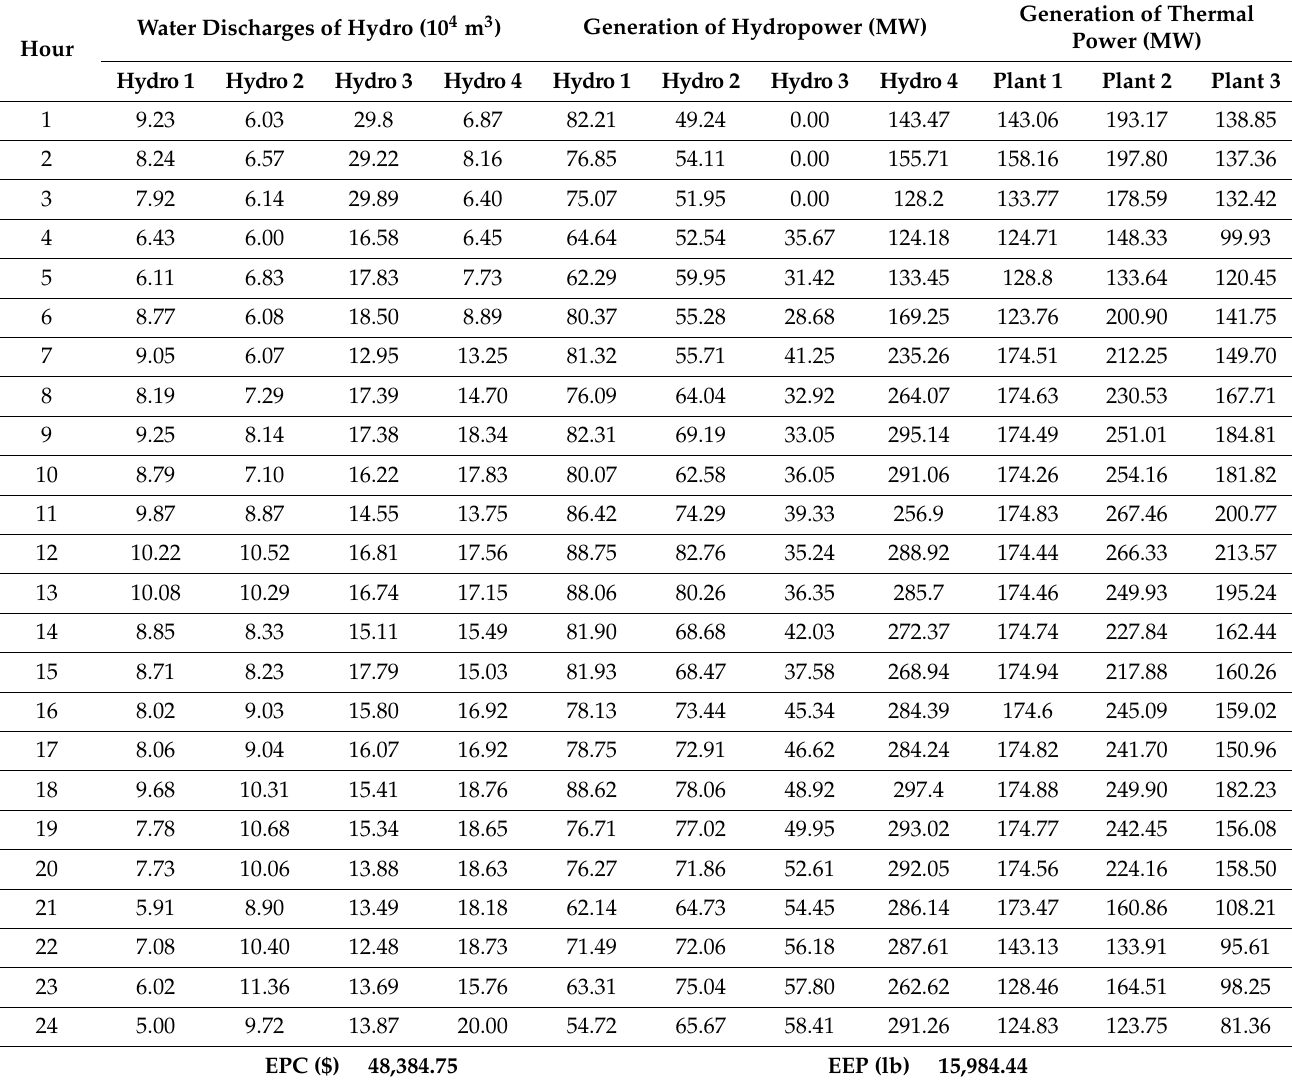
Table 3. EEP minimization schedule results with DOGSA of Test system-I.